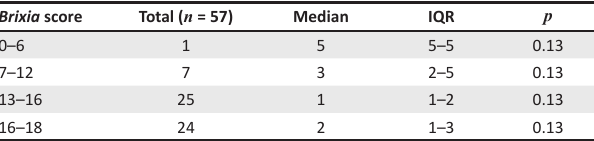
FIGURE 3: Graphical representation of days to death and Brixia score. TABLE 3: Number of days between X-ray and demise.